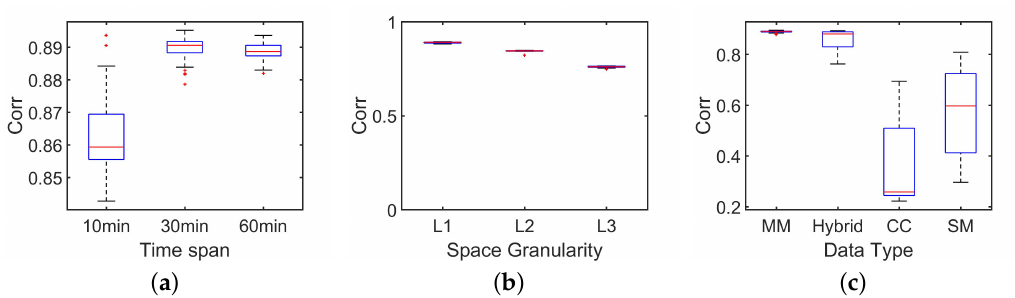
Figure 10. Accuracy evaluation based on correlation. ( a ) correlation with different time slot; ( b ) correlation at different space granularity: L1(the smallest space unit), L2, L3 (administrate units); ( c ) correlation with different data: MM (mobility management data), CC (call records), SM (short message logs).